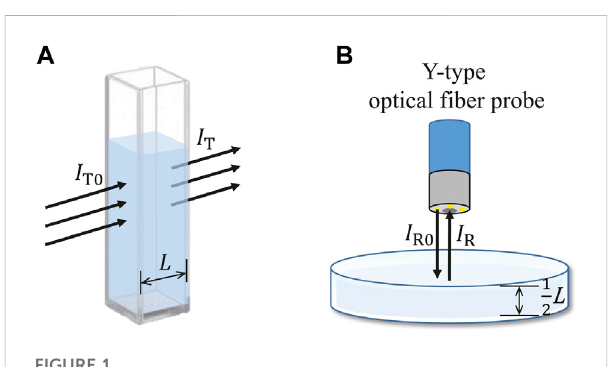
FIGURE 1 (A) The principle of the transmissive detection system. (B) The principle of the re fl ective detection